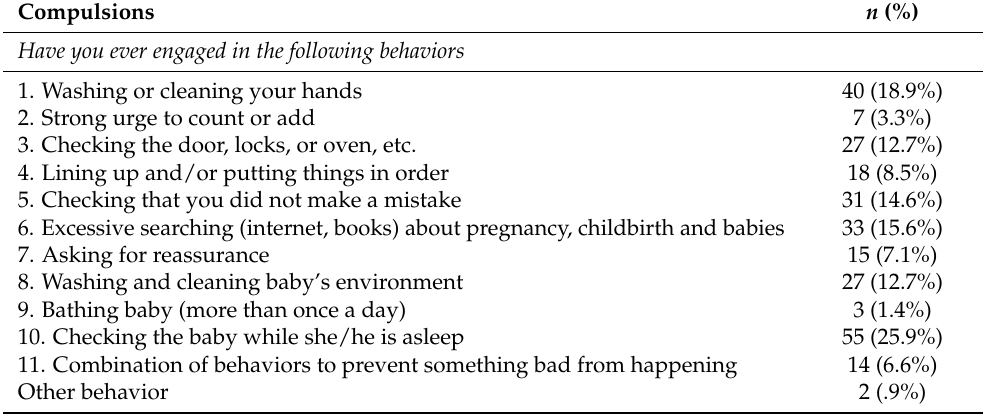
Table 6. Prevalence of repeated behaviors in the postpartum considering participants with at least one compulsion ( n =